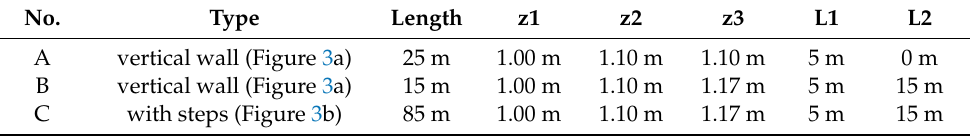
Figure 3. Cross-section of the quay at Riva S. Marco, in correspondence of the vertical wall ( a ) and of the descending steps ( b ). The water depths are referred to ZMPS.